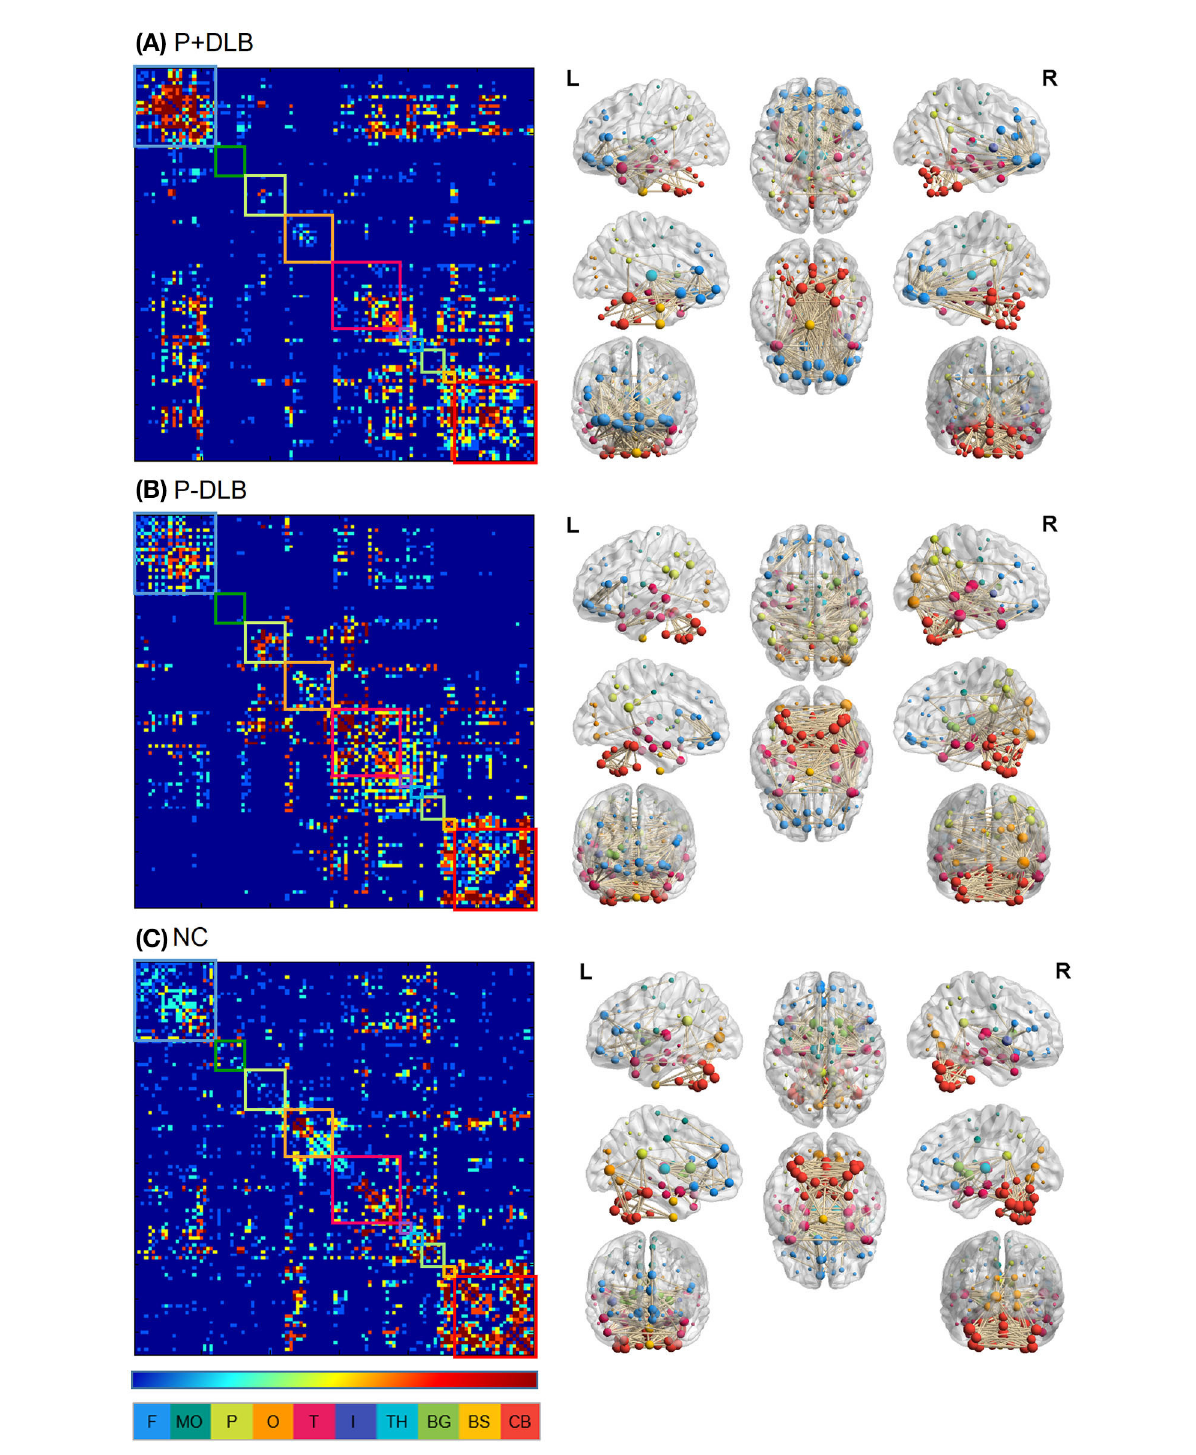
FIGURE1 Intra- and inter-regional connectivity matrices of the (A) P + DLB, (B) P-DLB, and (C) NC groups. Full connectivity matrices in the left column were obtained from 116 nodes. The color bar represents the strength of connectivity, with red representing stronger connectivity, and blue representing weaker connectivity. Each box represents the 10 subdivisions, which are F, MC, P, O, T, I, TH, BG, BS, and CB. The color of each subdivision matches the color of the node in the brain template in the right column. We display connectivity matrices on 3D brain templates on the right column. P + DLB, dementia with Lewy bodies with parkinsonism; P-DLB, dementia with Lewy bodies without parkinsonism; NC, normal controls; F, frontal; MC, motor cortex; P, parietal; O, occipital; T, temporal; I, insular; TH, thalamus; BG, basal ganglia; BS, brainstem; CB,